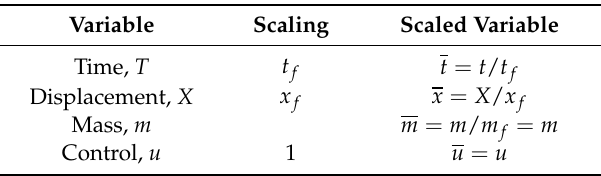
Figure 7. Pseudospectral optimal scaled-control. Normalized (scaled) time is the abscissa, while normalized (scaled) control is the ordinate. Reminder: variable scaling is in Table 7. Table 7. Variable scaling 1 .